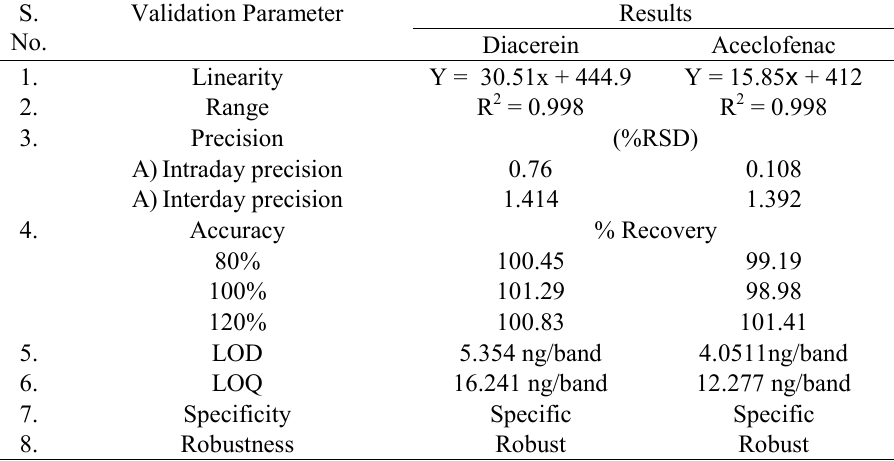
O , B- Mixture (500ng/band) treated with H 2 2